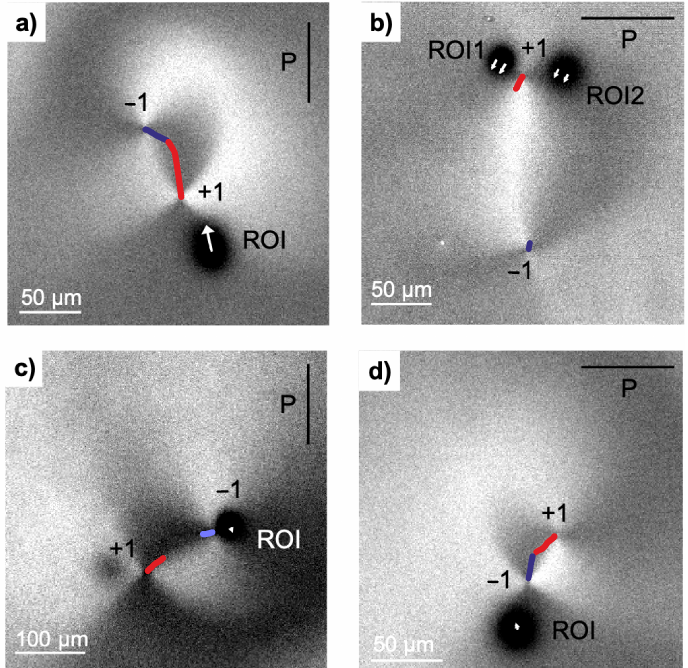
Figure 3. Trajectories of the defects and the flow field in the bleached regions: The snapshots show the pairs at the beginning of the recording, immediately after bleaching stopped. The + 1 defect, − 1 defect, and ROI trajectories are shown in red, blue and white respectively. The motion of the ROI near the positive defect ( a , b ) follows the motion of the defect. The ROI near the negative defect ( c , d ) does not move noticeably. ( a ) A single ROI bleach; ( b ) a double ROI bleach. The trajectories of the + 1 defect, of the − 1 defect, and of the ROI are shown in red, blue and white, respectively. The disclinations and ROI are tracked for 8 s. The position of the excitation beam polarization is given by black lines.